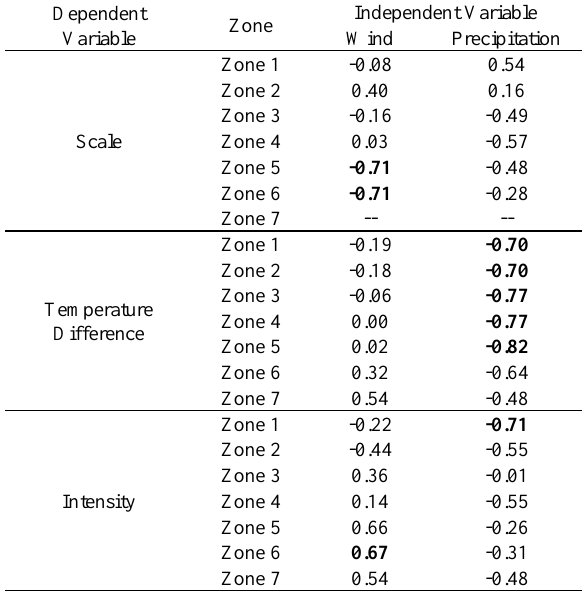
Table 6. Summary of Pearson correlation analysis between UCI indices and meteorological conditions (r values in bold text are statistically significant with p < 0.05)